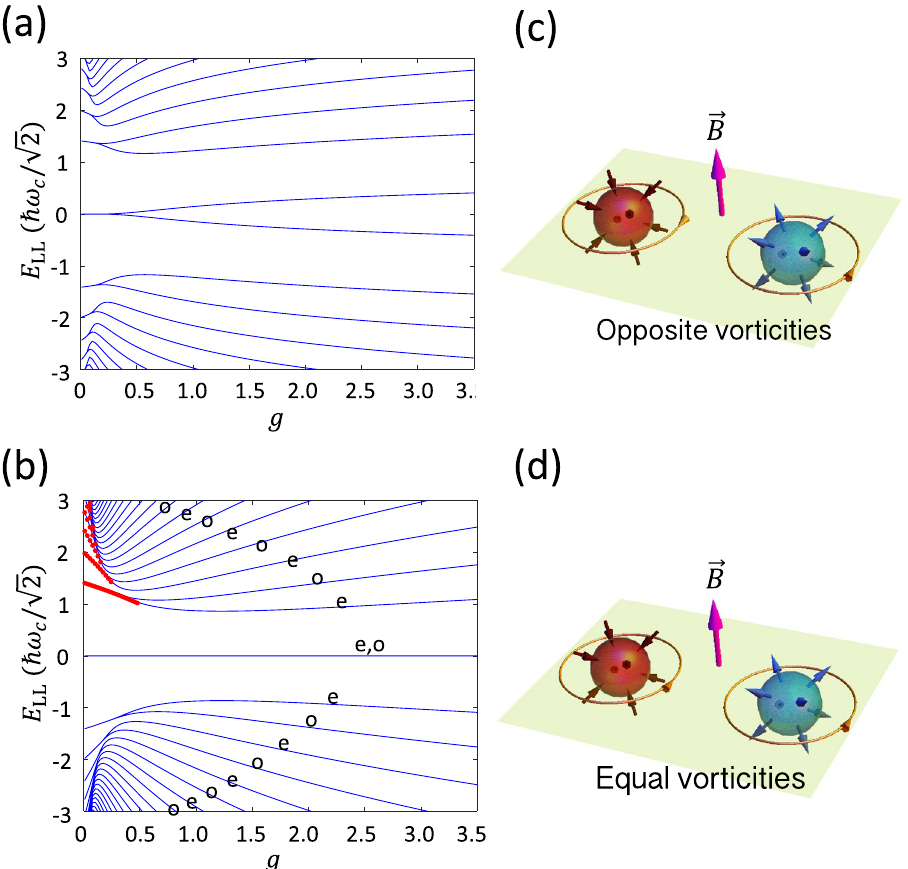
0.05 for both Model A 0 with respect to the coupling measure g with α Figure 1. The LL spectra at k z ˜ = = ( a ), and for Model B ( b ). In ( b ), Labels “e” and “o” denote even and odd parity of states, and the red dots are the 0 . ( c , d ) Illustrations of topological numbers of Weyl analytical solutions, except zero-energy ones, when α = nodes, including chirality and vorticity, for Model A ( c ) and Model B ( d ). Chirality is identified by the outward or inward Berry flux, while vorticity is the directional winding number around a Weyl